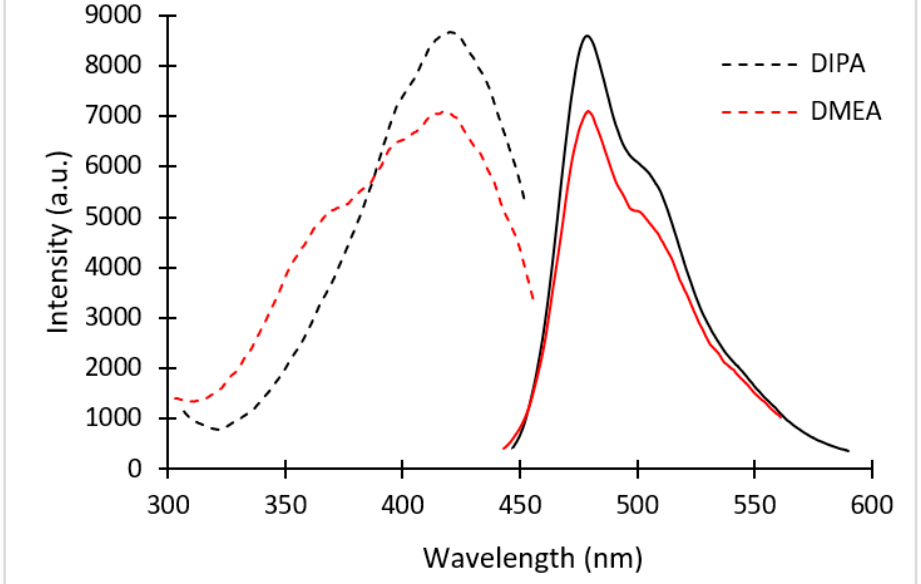
Figure 8. Fluorescence spectra of 6 × 10 − 3 M DIPA in acetonitrile: excitation ( λ em = 479 nm; black, dotted line), emission at λ ex = 419 nm (black, solid line) and of 6 × 10 − 3 M DMEA in acetonitrile: excitation ( λ em = 479 nm; red, dotted line) and emission at ( λ ex = 419 nm; red, solid line) within 1 day after the solution was prepared. All measurements were obtained at room temperature in a 1 × 1 cm (optical path) quartz